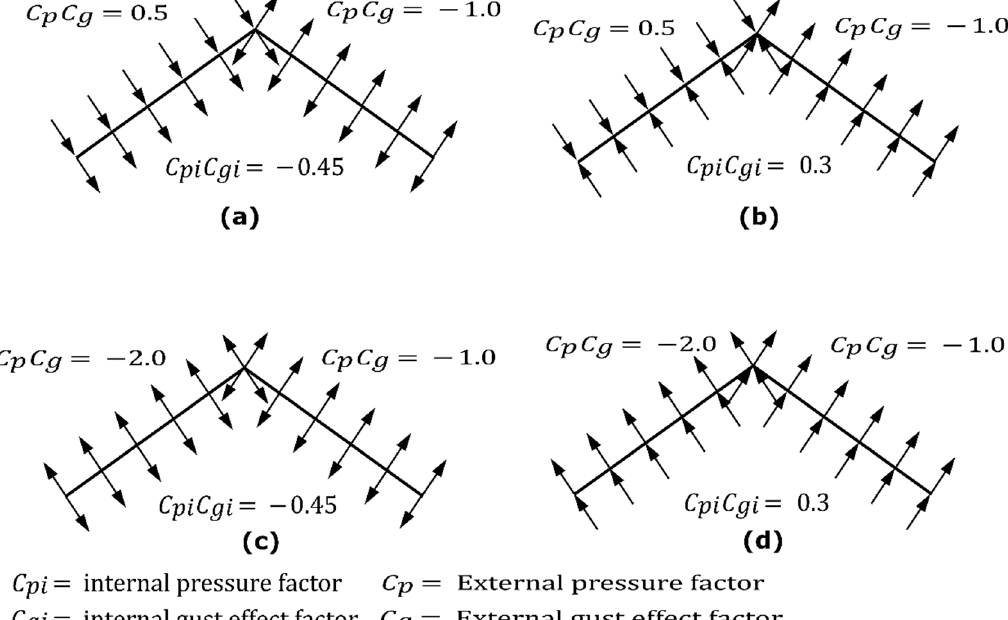
Figure 25. External and internal gust and pressure factors for wind load cases ( a , b ) for wind perpendicular to ridge and ( c , d ) for wind parallel to ridge.